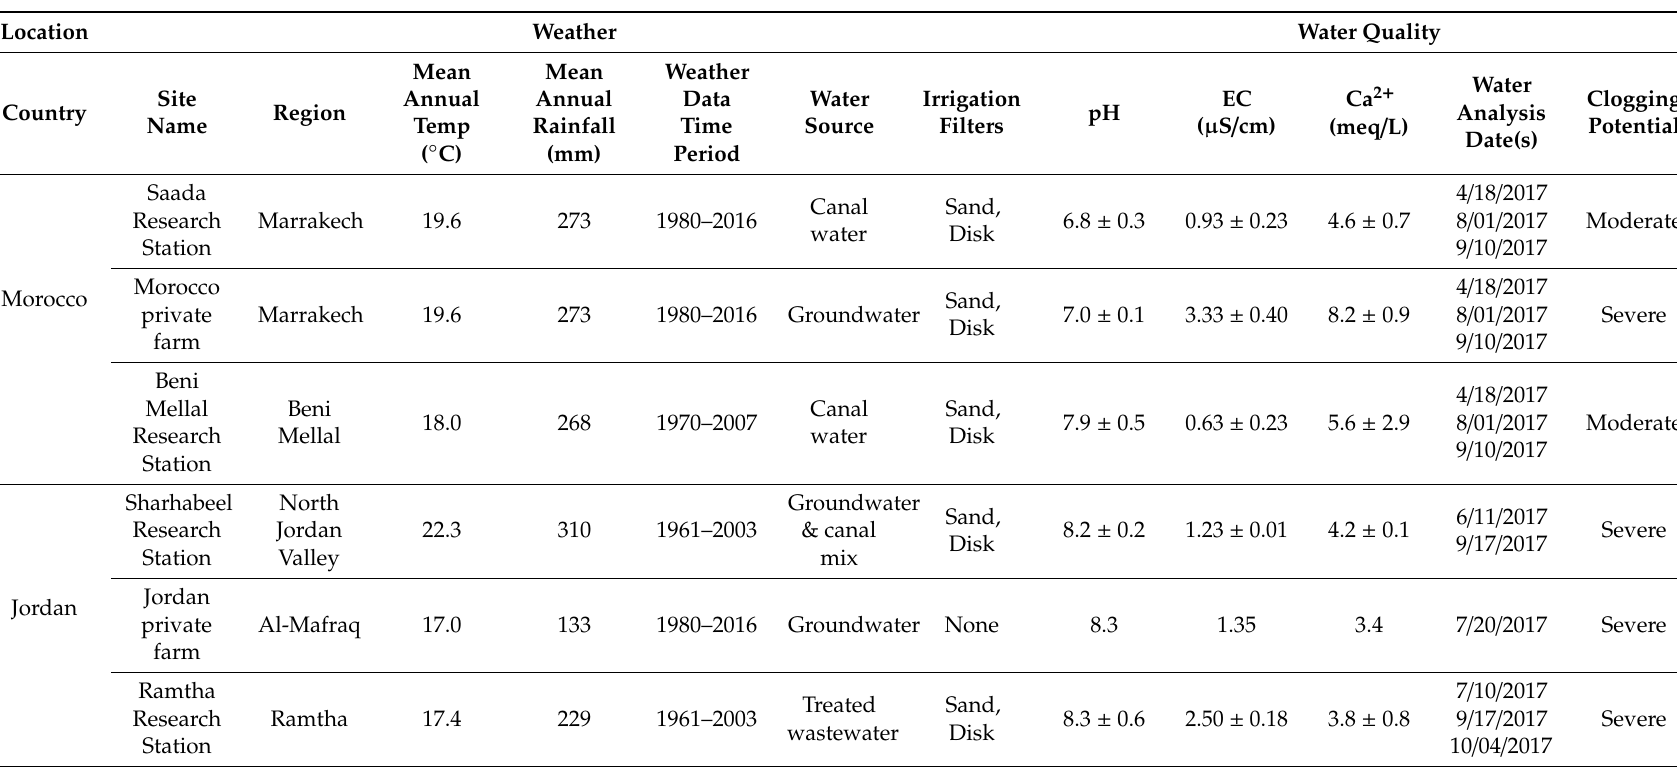
Table 1. Climatic conditions and water quality at experimental locations. Water was sampled from the reservoir (pre-filtration) one or more times throughout the 2017 irrigation season; for sites with more than one analysis, the mean of all measurements is listed with the standard deviation. Clogging potential is based on classification by Nakayama [18] using the mean values. Climate parameters are averages from years 1980–2016 [19], except for Beni Mellal Research Station with values averaged from 1970–2007 [12], and Sharhabeel and Ramtha Research Stations with values averaged from 1961–2003